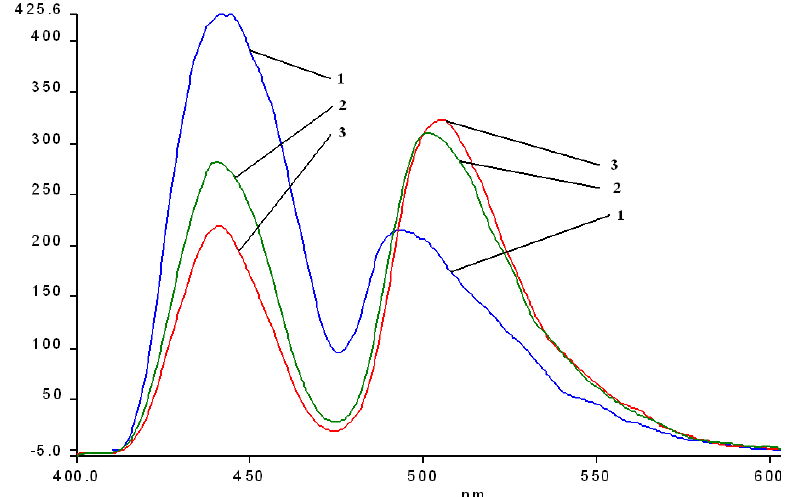
Figure 11. Overlapped emission spectra of hybrid nanomaterials obtained by impregnation of 2a (line 1) into the silica matrix: 2a-A (line 2); 2a-AB (line 3) in THF, at the same concentration.